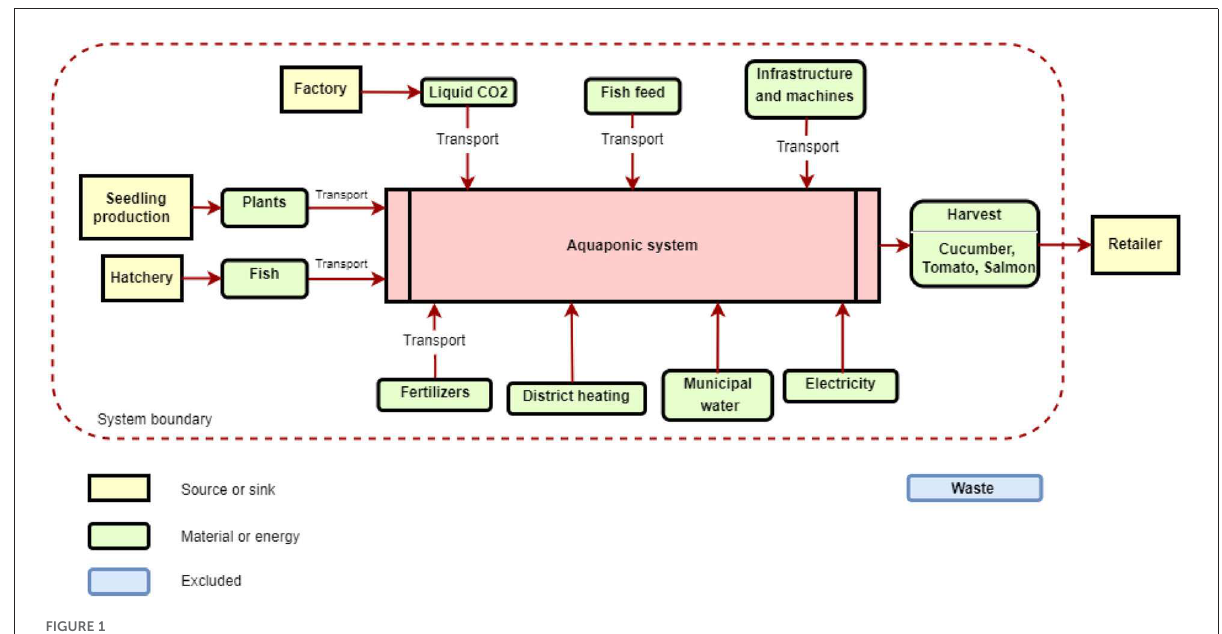
FIGURE1 Product system and system